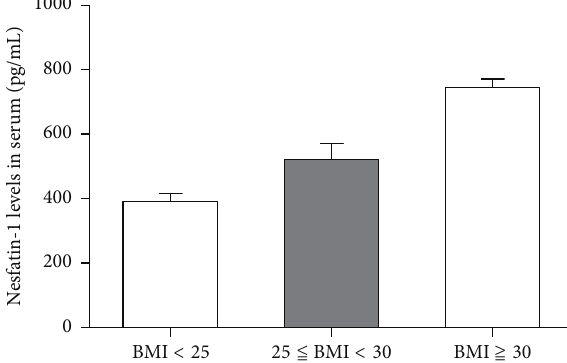
Figure 4: Different Nesfatin-1 levels in serum of OA patients with different BMI. On different BMI stratifications, the nesfatin-1 levels in serum, respectively, were 391.34 ± 115.81 (BMI ≦ 25 ), 520.87 ± 192.41 ( 25 < BMI ≦ 30 ), and 745.21 ± 45.24 (BMI ≧ 30 ). Kruskal- Wallis test showed 𝜒 2 = 13.59 , 𝑃 = 0.001